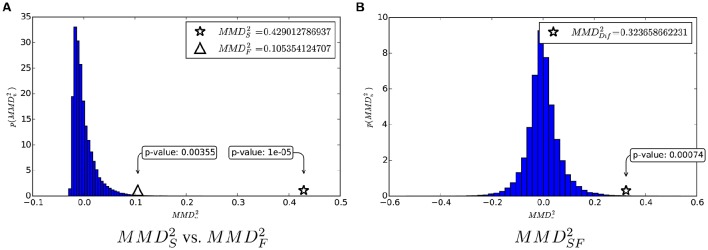
(A) Comparison of structural MMDS2 and functional MMDF2 according to their common null distribution. (B)
MMDSF2 and its null distribution.